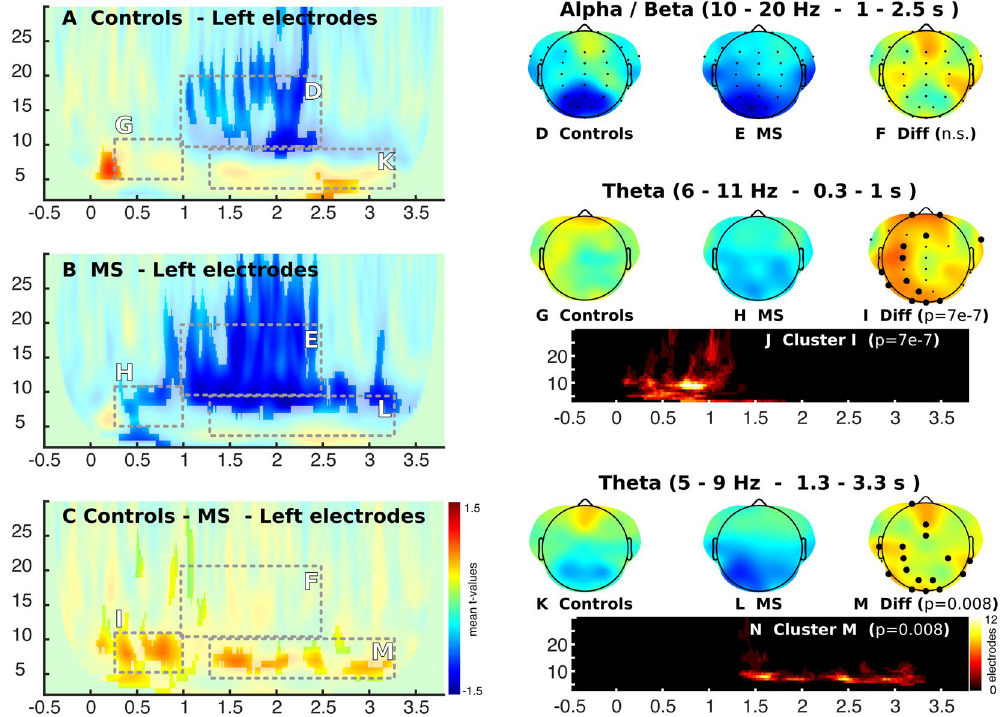
Figure 3. Time-frequency analysis of the effect of memory load (ML) on the difference between multiple sclerosis patients (MS) and healthy control (HC), for the different stages of the adapted Sternberg’s Memory Scanning Task described by Jensen et al . (2002). Color represents the mean T-value of the single trial regressions per subjects given by the following equation (Power (f,t) = b1 + b2 * ML + b3 * SMP). Significant regions are highlighted (CBP test p <